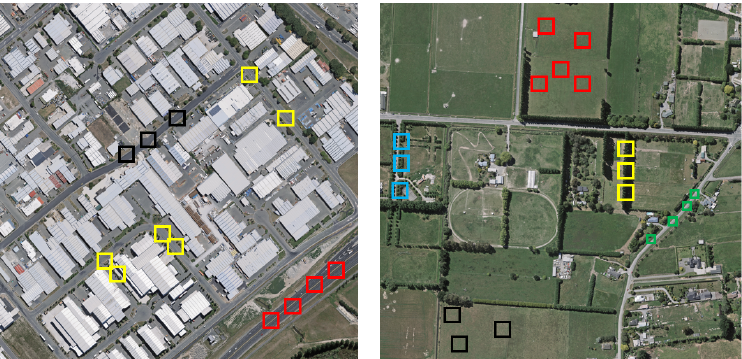
Figure 1. The redundancy contains remote sensing images. In each image, the same color means similar